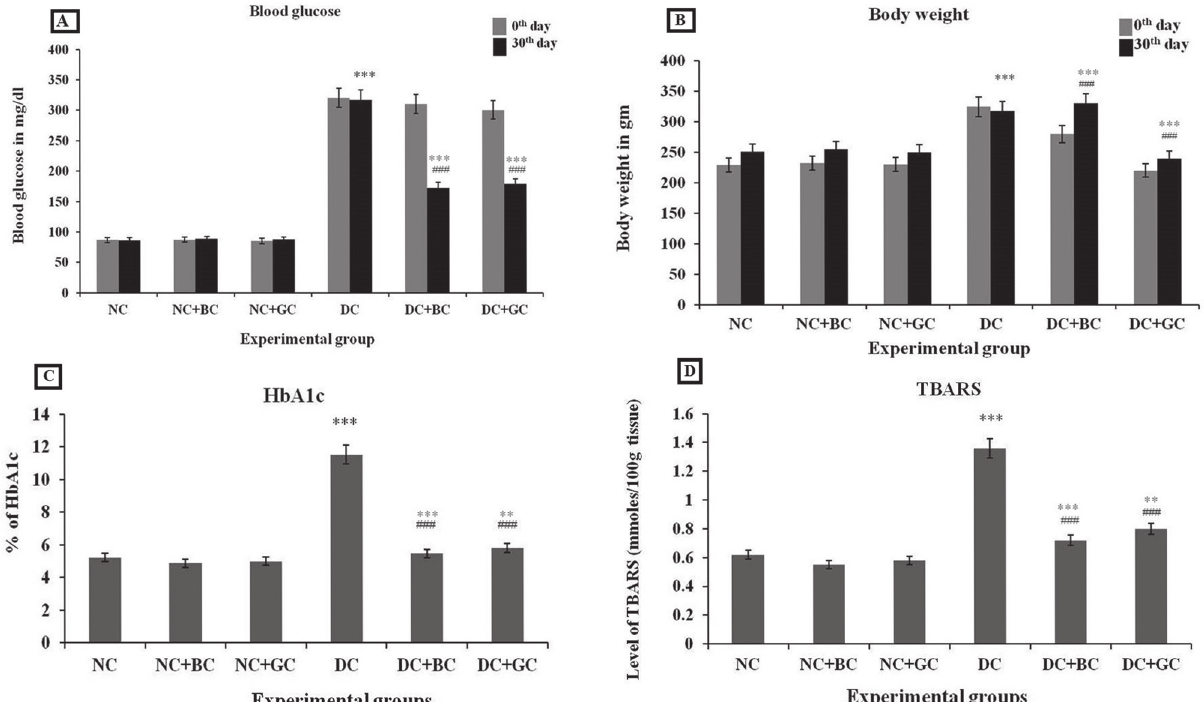
FIGURE 1 (A-D) - Effect of baicalein supplementation on blood glucose, body weight, % HbA1C and TBARS levels of rats in different experimental groups. Data were expressed as mean ± SD and analyzed using one-way ANOVA followed by Tukey’s Multiple Comparison Tests. Values are statistically significant at P < 0.05; **P < 0.05; ***P < 0.01 when compared with control group and ## P < 0.05; ### P < 0.01 when compared with diabetic group. NC: normal control, NC+BC: normal control treated with baicalein, NC+GC: normal control treated with glibenclamide, DC: diabetic control, DC+BC: diabetic rats treated with baicalein, DC+GC: diabetic rats treated with